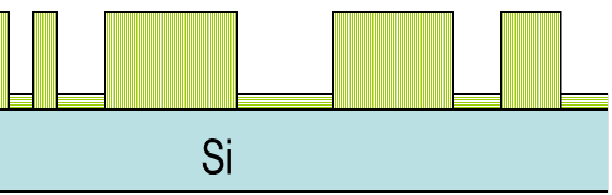
Figure 9. A proposed C 32 H 66 layer structure of two oriented molecules based on AFM line scanning profile of Figure 1. The model fit for low C 32 H 66 concentration deposition.